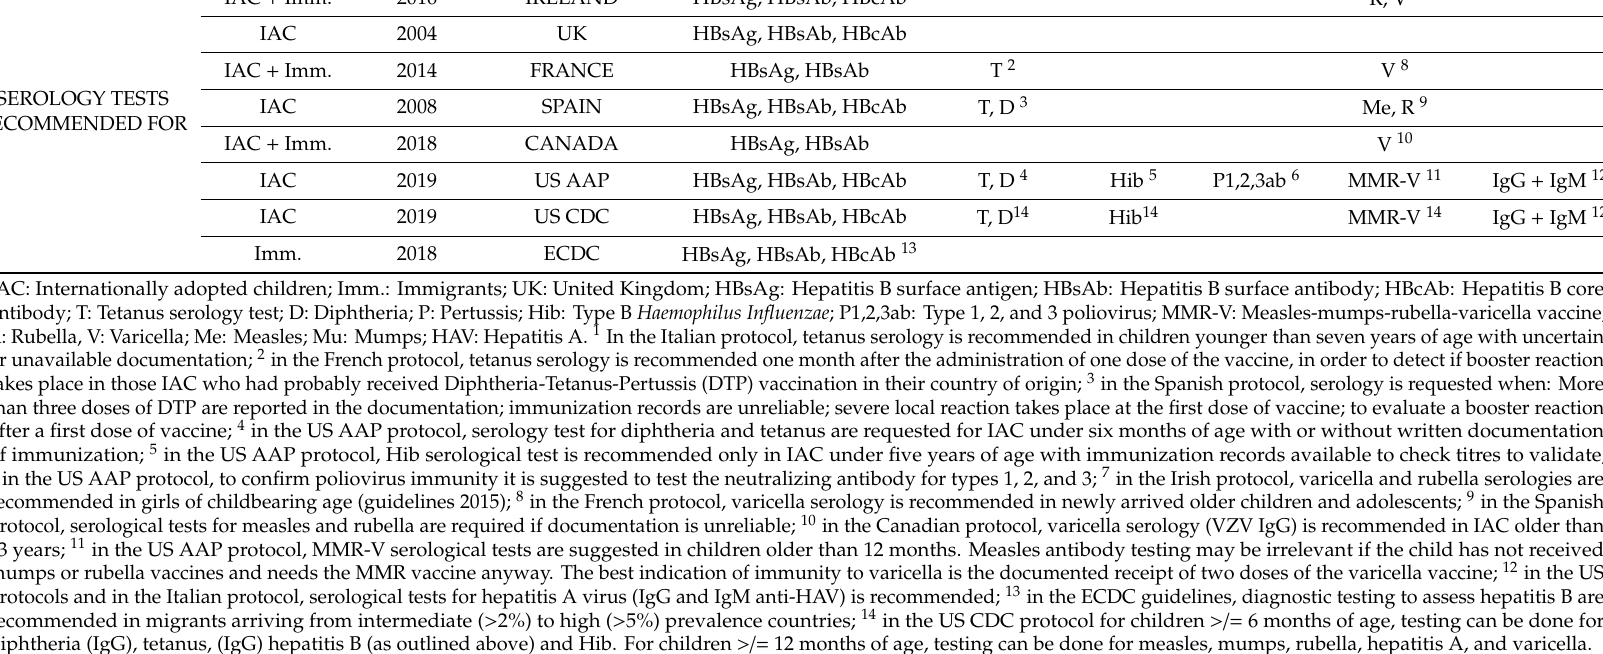
Table 1. Serology tests recommended by di ff erent western countries to assess the immunization status of newly arrived Internationally Adopted Children (IAC). Country Refers to Year HBV DTP Hib POLIO MMR-V HAV Protocol: IAC + Imm. 2013 ITALY HBsAg, HBsAb T 1 IgG + IgM IAC + Imm. 2016 IRELAND HBsAg, HBsAb, HBcAb R, V 7 IAC 2004 UK HBsAg, HBsAb, HBcAb IAC + Imm. 2014 FRANCE HBsAg, HBsAb T 2 V 8 SEROLOGY TESTS IAC 2008 SPAIN HBsAg, HBsAb, HBcAb T, D 3 Me, R 9 RECOMMENDED FOR IAC + Imm. 2018 CANADA HBsAg, HBsAb V 10 IAC 2019 US AAP HBsAg, HBsAb, HBcAb T, D 4 Hib 5 P1,2,3ab 6 MMR-V 11 IgG + IgM 12 IAC 2019 US CDC HBsAg, HBsAb, HBcAb T, D 14 Hib 14 MMR-V 14 IgG + IgM 12 Imm. 2018 ECDC HBsAg, HBsAb, HBcAb